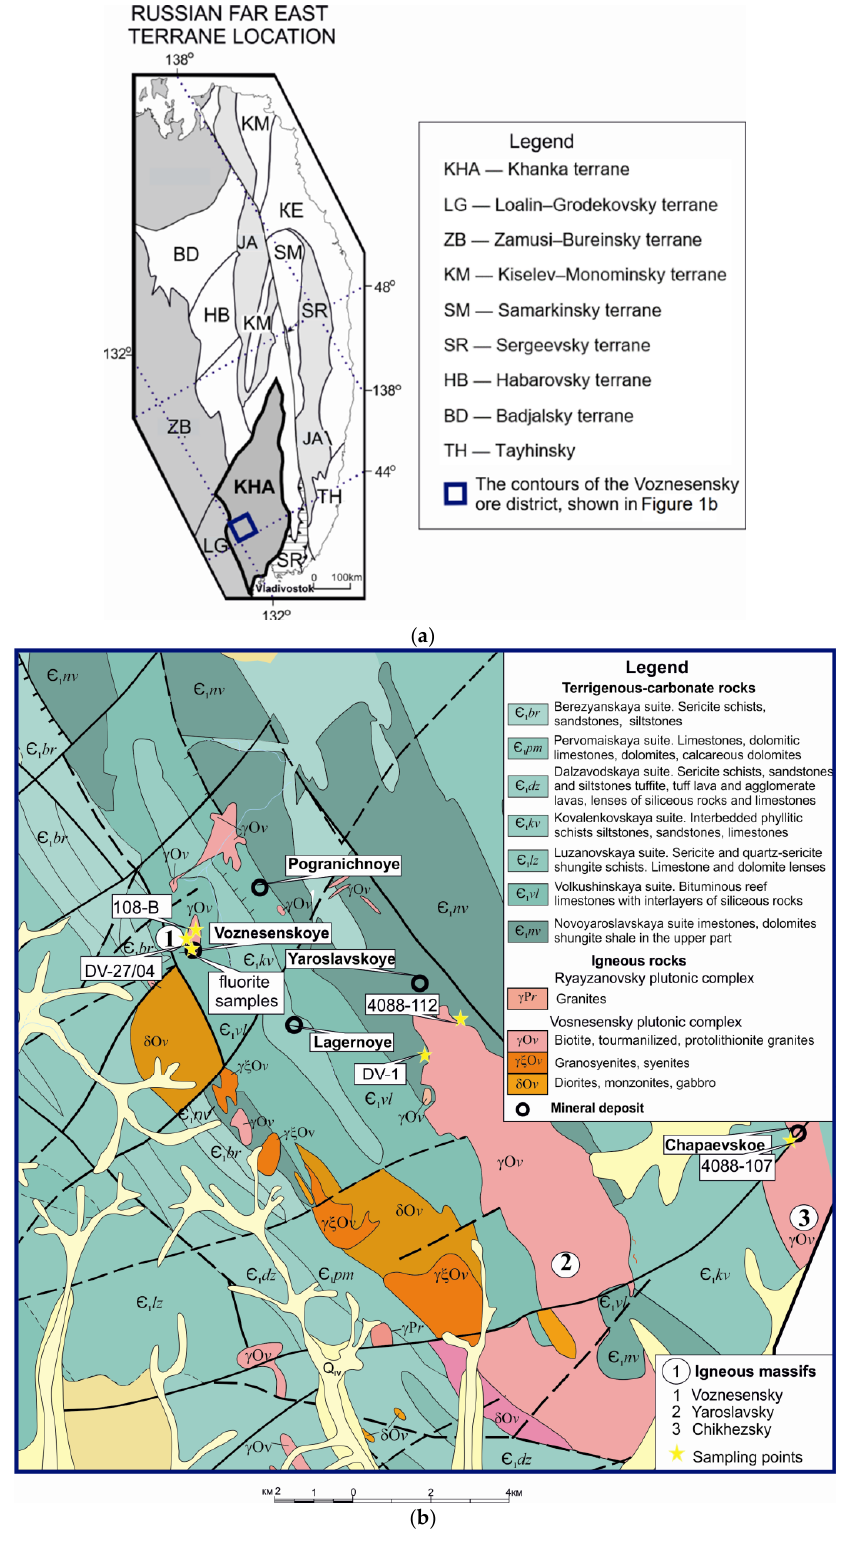
Figure 1. ( a ) Tectonic sketch map of the Russian Far East terrane, emphasizing position of the Khanka massif; ( b ) simplified geological map of the part of the Khanka massif (based on the materials of Primorgeologiya OJSC, S.V. Kovalenko et al.), showing Voznesenskoe rare-metal–fluorite and Yaroslavskoe and Chapaevskoe tin ore deposits and sample locations. Sampling locations are shown as yellow